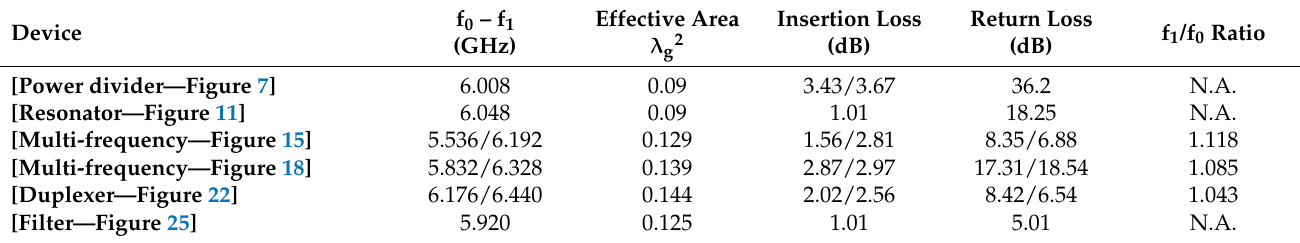
Table 1. Summary of the relevant